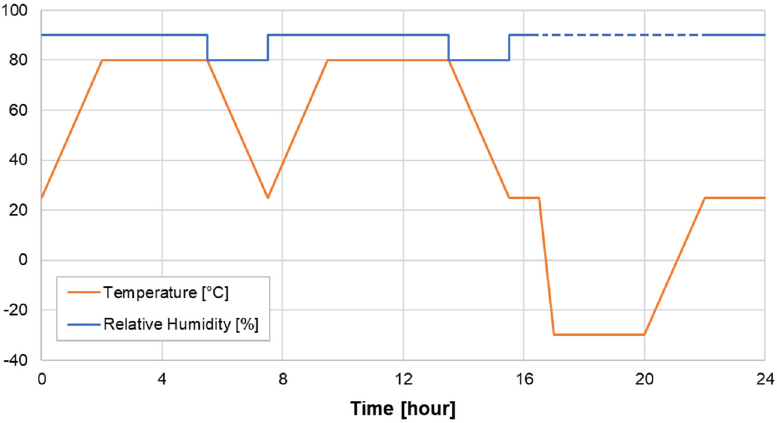
Figure 1. Controlled temperature and humidity diagram for the aging cycle IEC 60068.